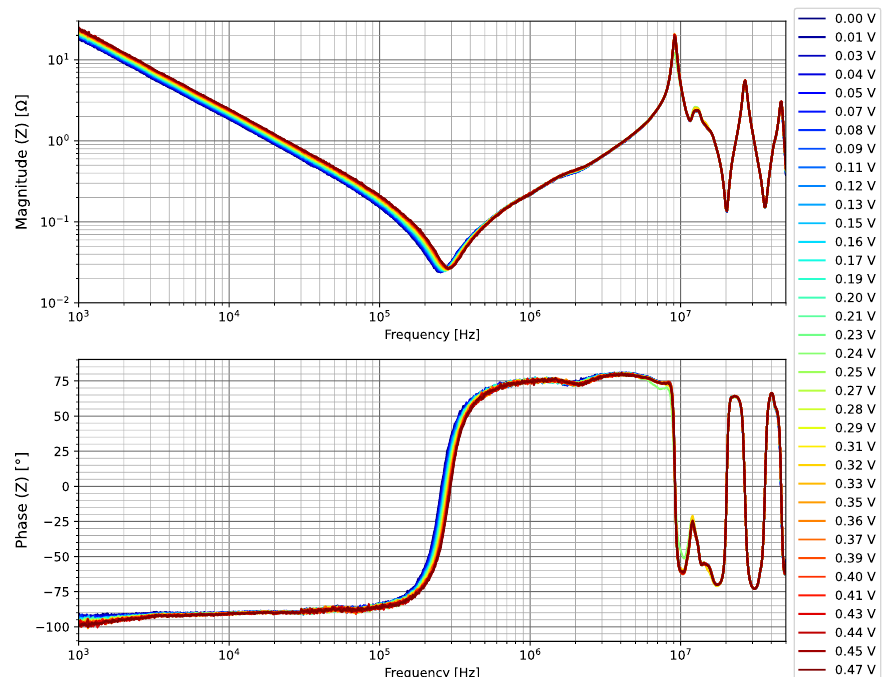
Figure 28. Large PV module measured per-cell impedance curves at multiple levels of reverse bias (frequency range 1 kHz to 50 MHz).